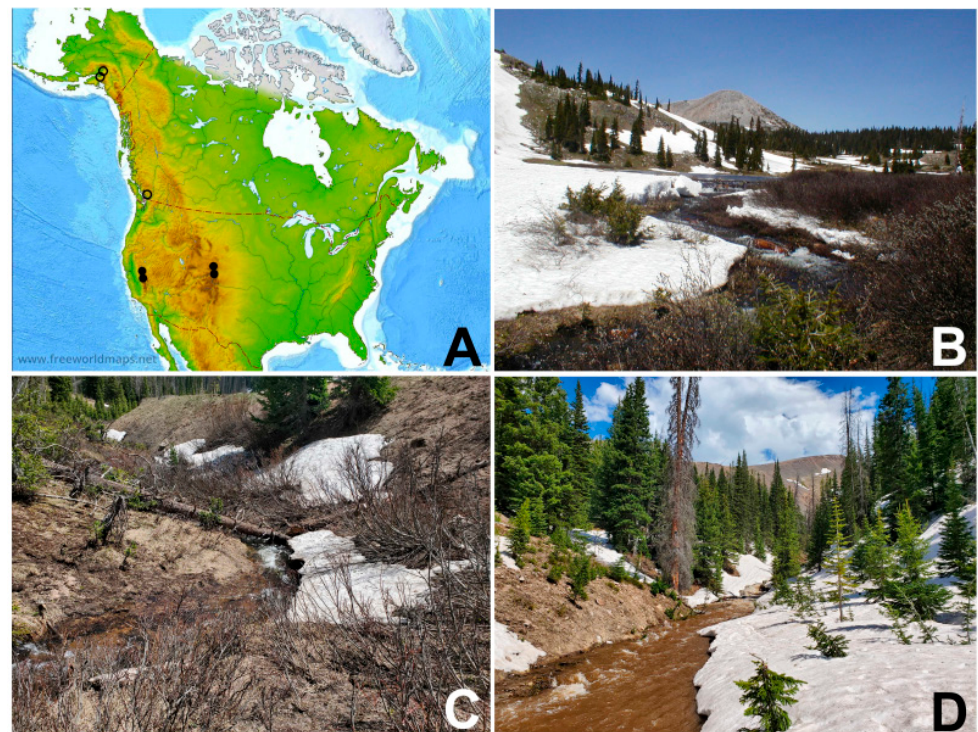
Figure 1. Collecting sites for Prosimulium supernum n. sp. ( A ) Map of North America. Solid black circles represent P. supernum n. sp. and open circles represent chromosomally confirmed records of its near relative P. esselbaughi ; map by Daniel Feher, https://www.freeworldmaps.net/about.html (accessed on 20 December 2022). ( B ) Type locality of P. supernum n. sp., Libby Creek, Wyoming, 12 June 2008. ( C ) Cameron Pass, snow melt tributary of Michigan River, Colorado, 11 June 2022 (site 2, Table 1). ( D ) Cameron Pass, Michigan Ditch, Colorado, 20 June 2022 (site 4, Table 1).